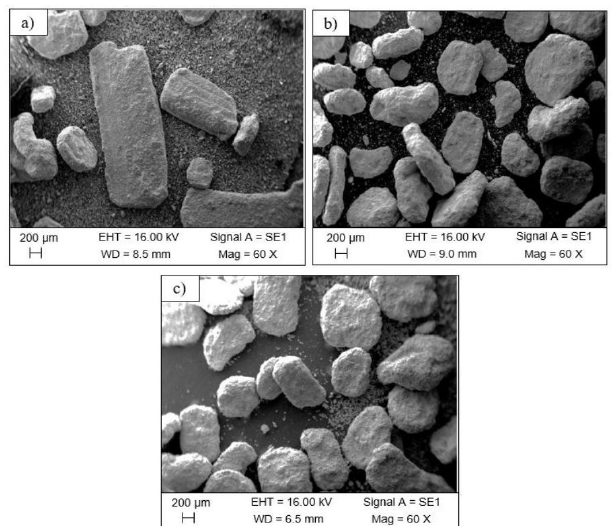
Figure 2: SEM micrographs of the Vanadis ® 8 steel with Mo